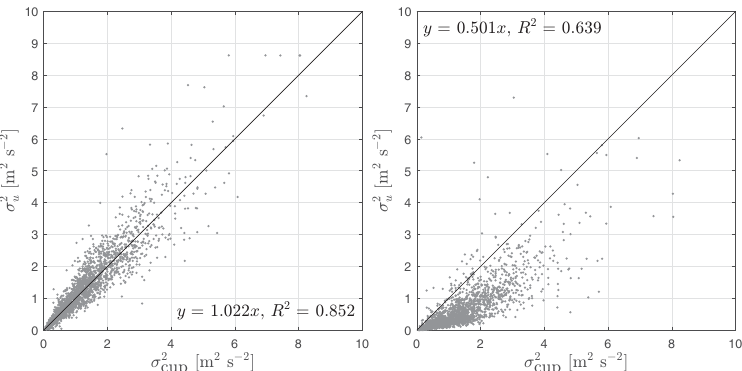
Figure 15. Comparison of the 80m cup anemometer and the unfiltered (left) and filtered (right) u variances from the ZephIR estimated Figure15.Comparisonofthe80-mcupanemometerandtheunfiltered(leftframe)andfiltered(rightframe) u -variancesfromtheZephIR estimated under the assumption of homogeneous turbulence within the measurement volume (see text for details). We show a 1:1 line for guidance.Resultsofalinearregressionthroughtheoriginand R 2 arealsogiven Results of a linear regression through the origin and R 2 are also We also compare the lidar-derived σ 2 and u (cid:2) w (cid:2) -values with the sonic-anemometer estimates; the biases are very high and v,w R 2 -valuesareverylow(notshown).Thisisnotsurprisinggiventheweightofthe σ 2 v,w and u (cid:2) w (cid:2) -termsinEqn.(10)whenusing low ϕ -values.Withthislidarconfiguration,thereconstructionofthe v -componentisnotsoundeither,e.g.fromEqn.(14);the yaw misalignment based on both the Avent and ZephIR reconstructed u - and v -components shows poor agreement when comparedtothedifferencebetweenthewind-vaneandtheturbine-yaw10-minsignals. 5